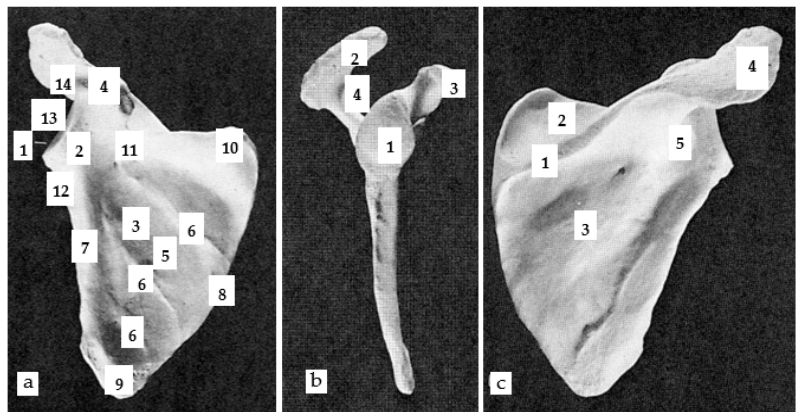
Figure 5. The ( a ) right ventral view, ( b ) right lateral view and ( c ) right dorsal view of scapula